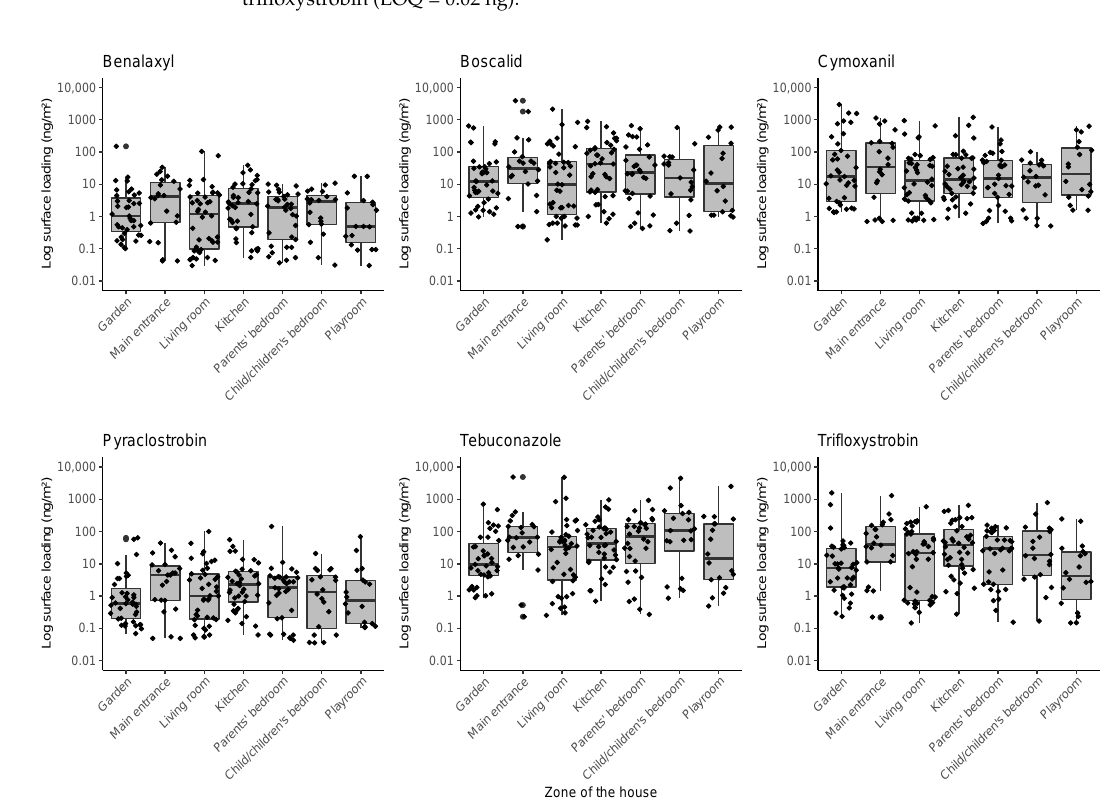
Figure 1. Log—pesticide surface loadings (ng/m 2 ) according to the zone sampled (N =